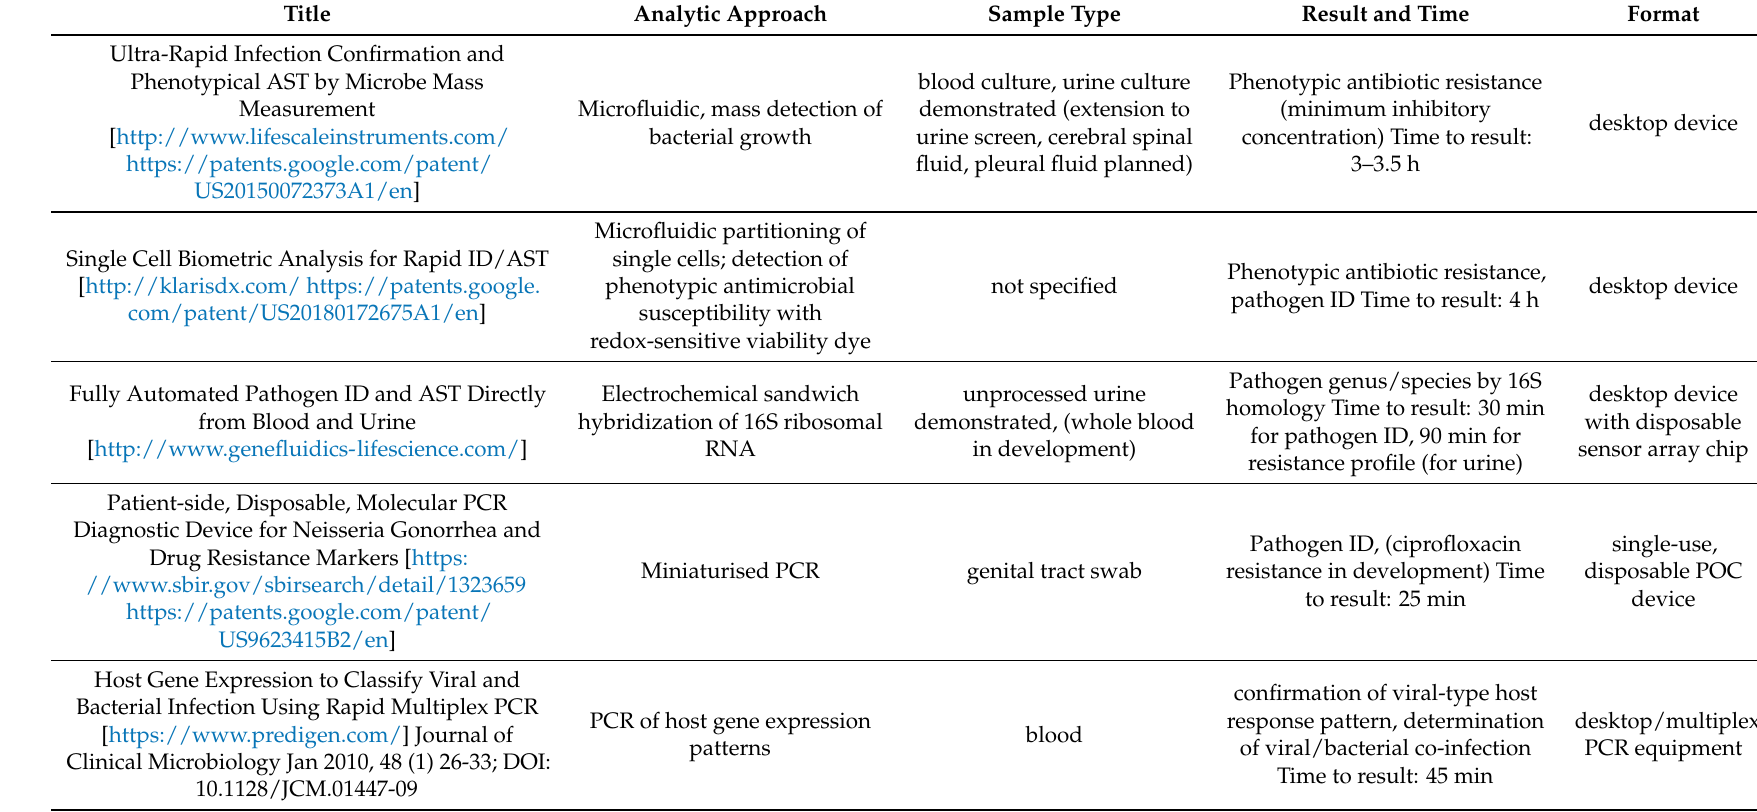
Table 2. AMR Challenge